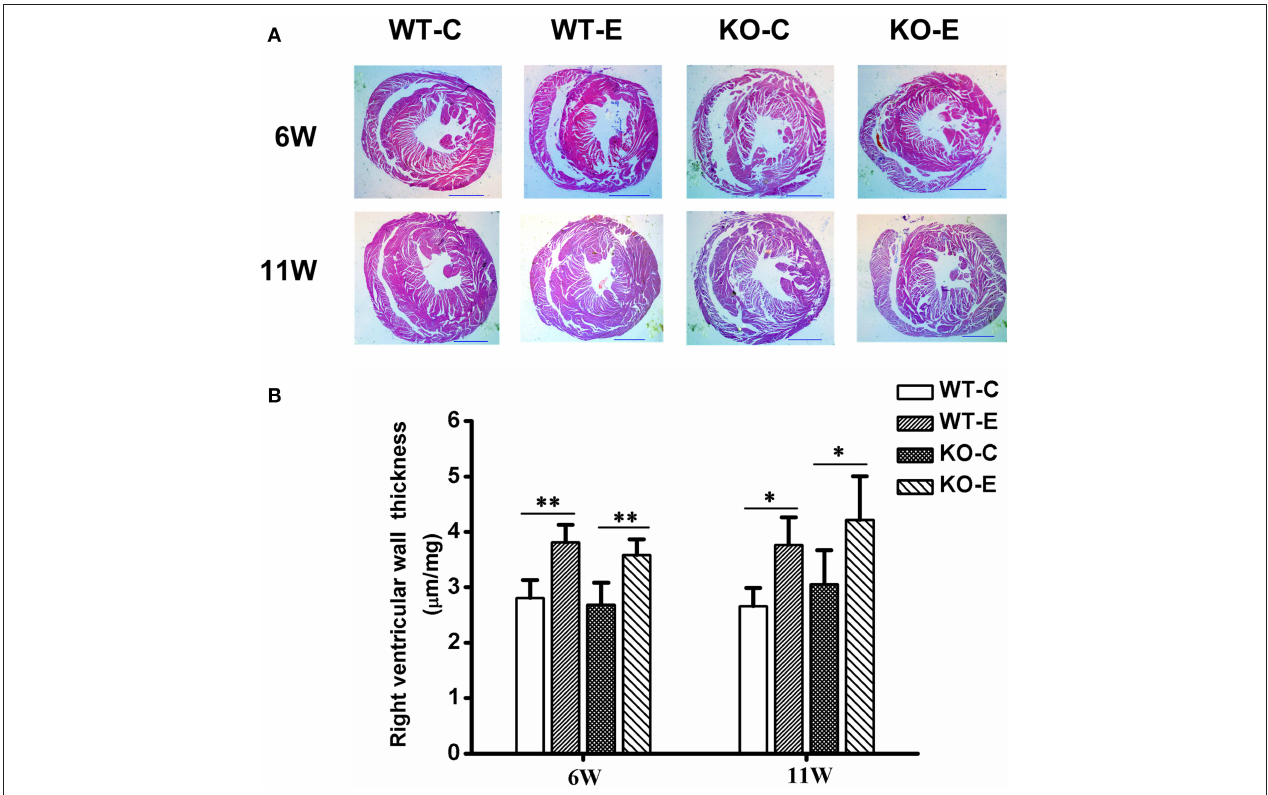
FIGURE 2 | Histopathology results. For 6 or 11 weeks, 6–8-weeks C57/B6 mice, with or without Nrf2 knockout, were exposed to either filtered air or air containing particulate matter (PM), and the hearts were then collected, fixed in 4% buffered formaldehyde for 24h, and then histologically processed for hematoxylin and eosin staining. The right ventricular wall thickness was then measured and analyzed. N = 3–4 per group. WT-C, wildtype control; WT-E, wildtype exposed; KO-C, knockout control; KO-E, knockout exposed. (A) Representative hematoxylin and eosin stained sections for WT-C, WT-E, KO-C, and KO-E groups after 6- or 11-weeks treatment. Scale bars represent 1,000 um. (B) Quantification of the right ventricular wall thickness. *Statistically different between the two groups ( P < 0.05). **Statistically different between the two groups ( P <